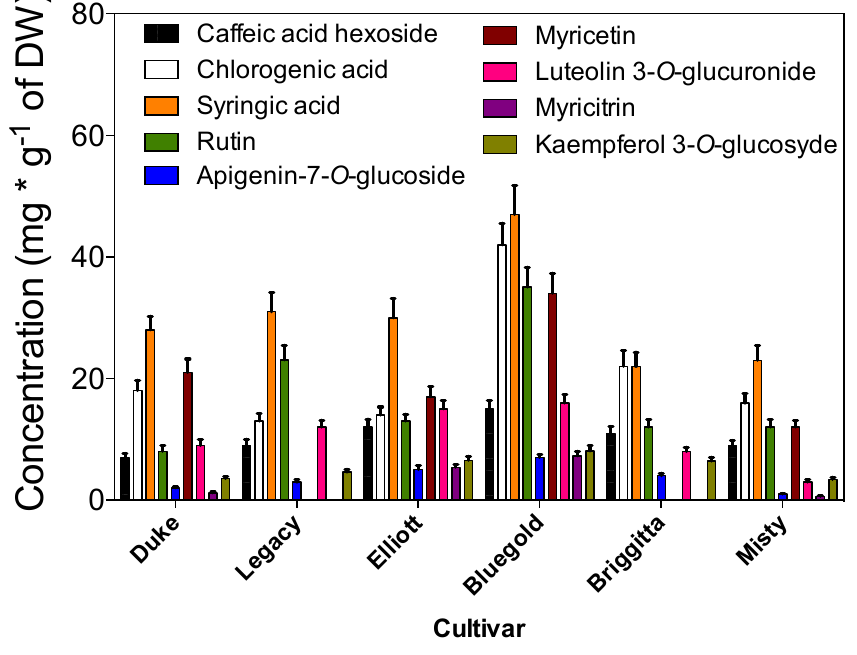
Figure 6. Total concentration of identified compounds in the six in vitro highbush blueberry cultivars. Each bar corresponds at the mean of three independent measurements ± standard error ( p <